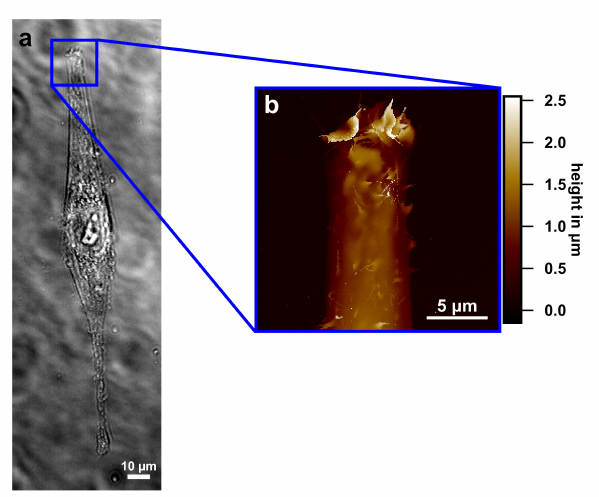
Figure 7. Fixed MG-63 cell after 24h adhesion time on BSA µ CP glass in PBS. ( a ) Brightfield image of a spindle-shaped cell oriented parallel to the molecule stripes. The blue square at the cell pole shows the area of investigation by SICM. ( b ) SICM-topography image of the cell pole. Bright colors mark high spots. Extensive membrane ruffling is visible. The ruffles (peripheral) at the edges are several µ m higher compared to the surrounding cell membrane, indicating that the cell either folded back its membrane or that the cell attempted to spread further and, therefore, provided membrane at the